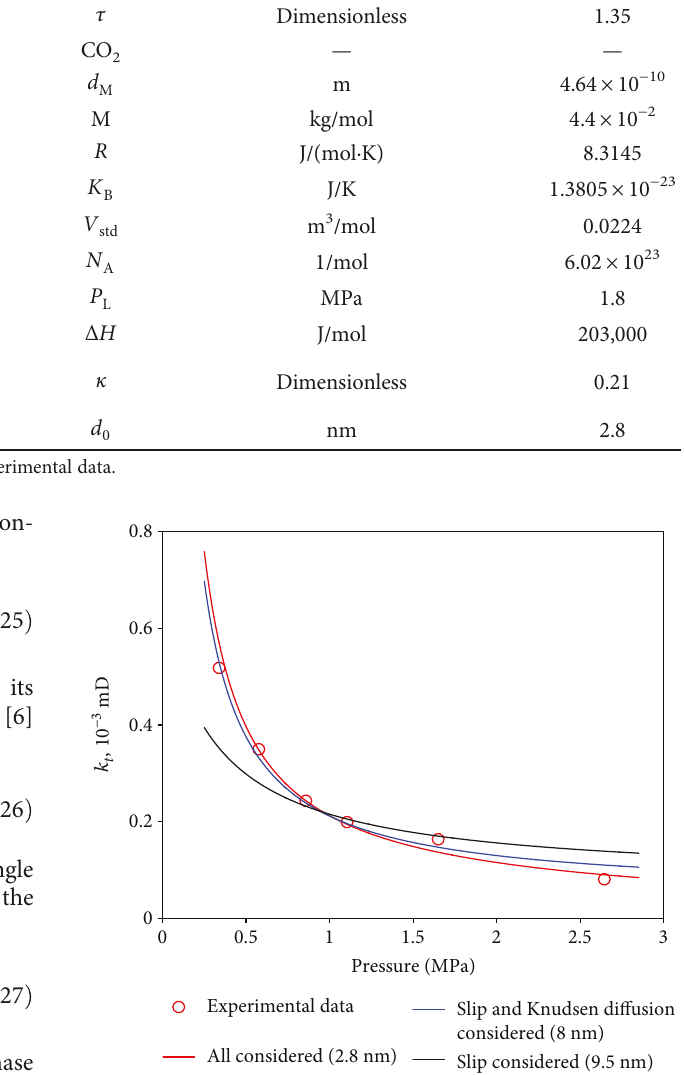
Figure 6: Validation of the proposed model with experimental data (from